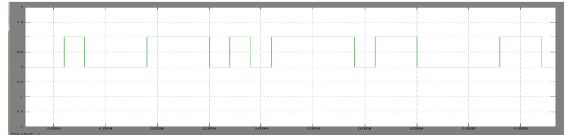
Fig. 11. Input Data Stream. After generating input sequence, it has been multiplied by a PN sequence of 32 chips and chip rate of 2Mbps to produce a DSSS signal. Figures 12 and 13 depict the PN sequence and input data after applying spreading technique